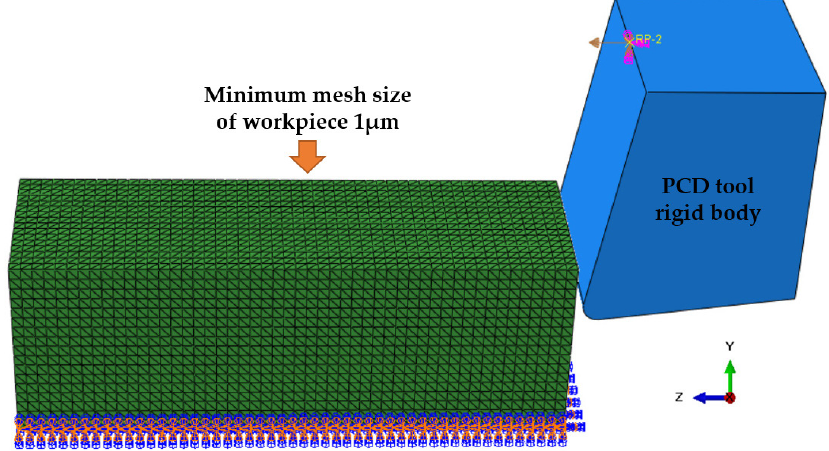
Figure 3. Diagram of boundary conditions of TiCp/TC4 composites.